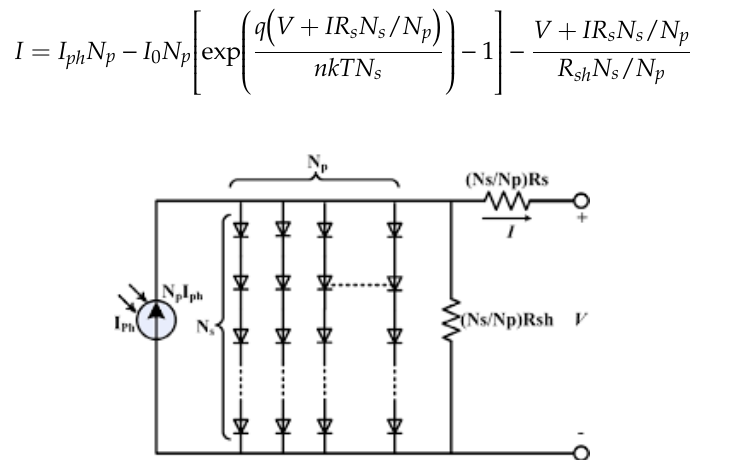
Figure 1. Equivalent circuit SDM of PV module.